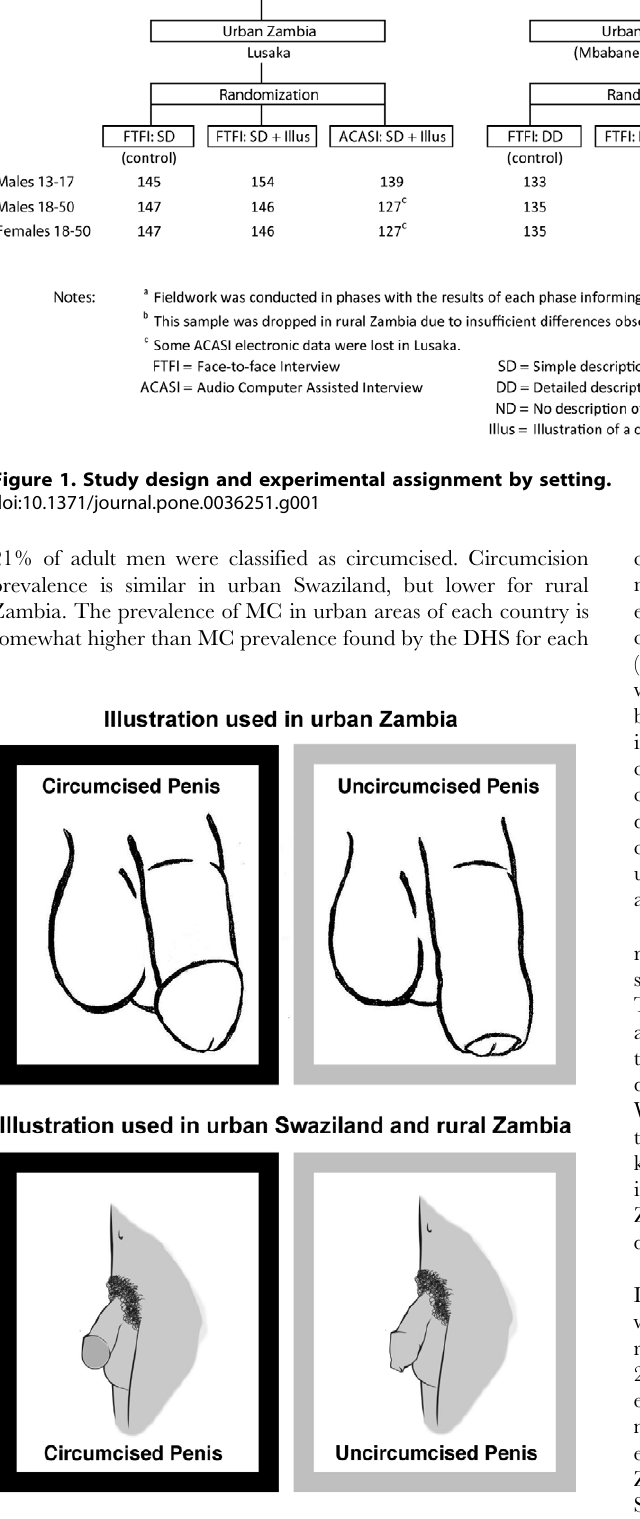
Figure 2. Illustrations of circumcised and uncircumcised penis.